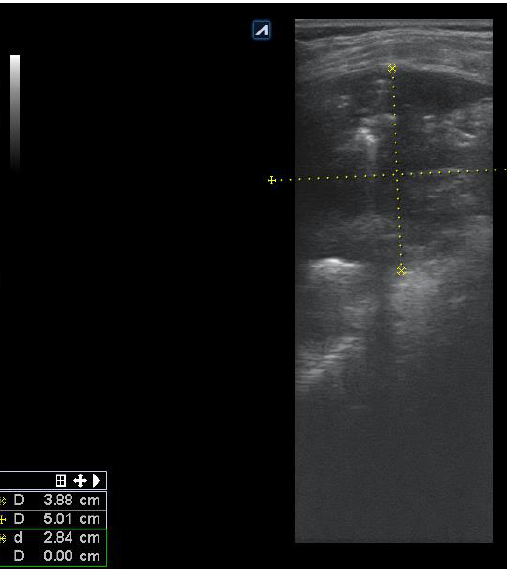
Figure 5. Persistence of consolidation (3.88/5.1 cm) with air bronchogram reabsorption of pleural effusion; 7 – 12 MHz, day 7.